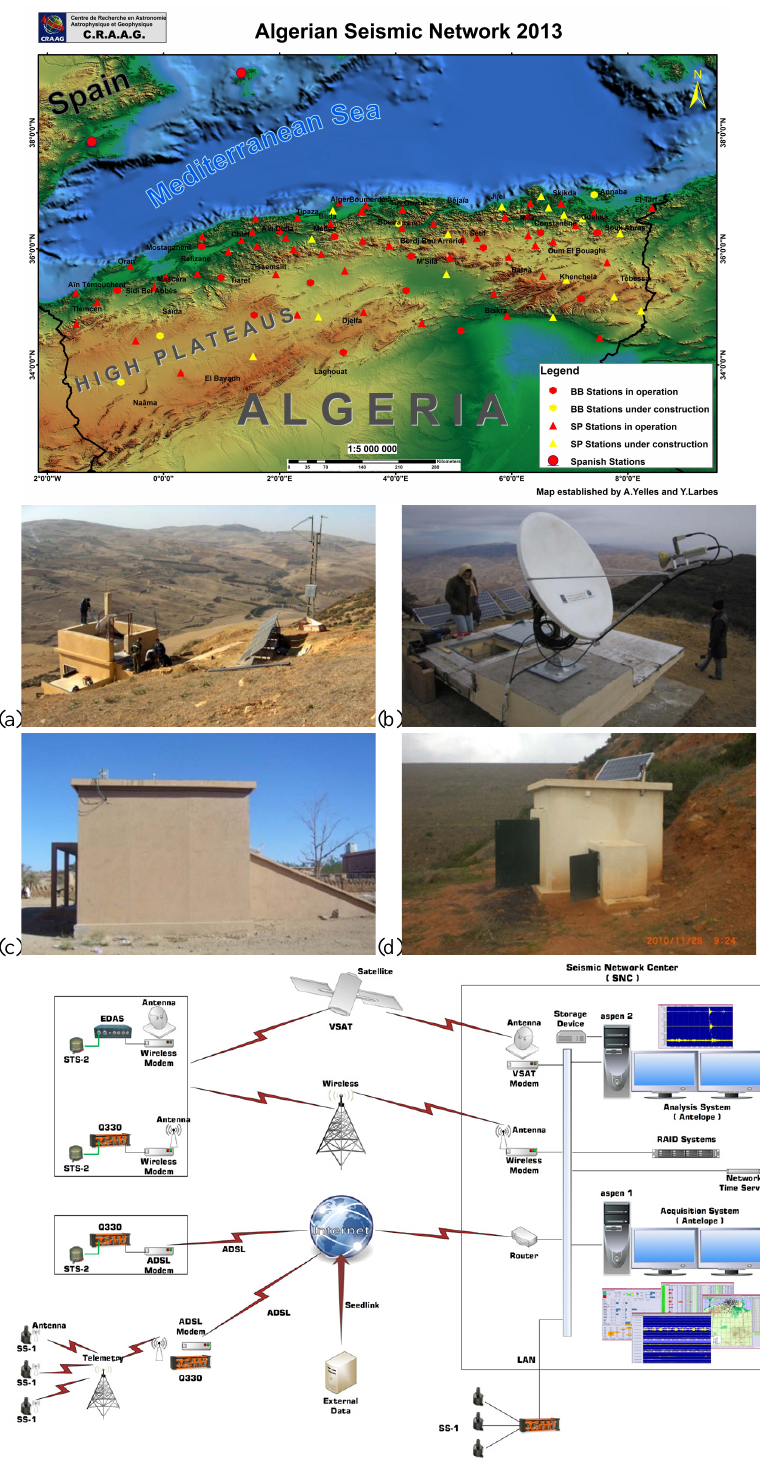
Fig. 2. The Algerian Digital Seismic Network in 2013. (a) Broad Band station (Mahouada, Algiers Network). (b) Broad Band station (Tessala, Oran network). (c) Very Broad Band station (Tamanrasset Observatory). (d) Short Period Station (Keddara dam, Algiers network). (e) Near Real-time data acquisition process. From data acquisition in the station to the reception in the Seismic Center of the